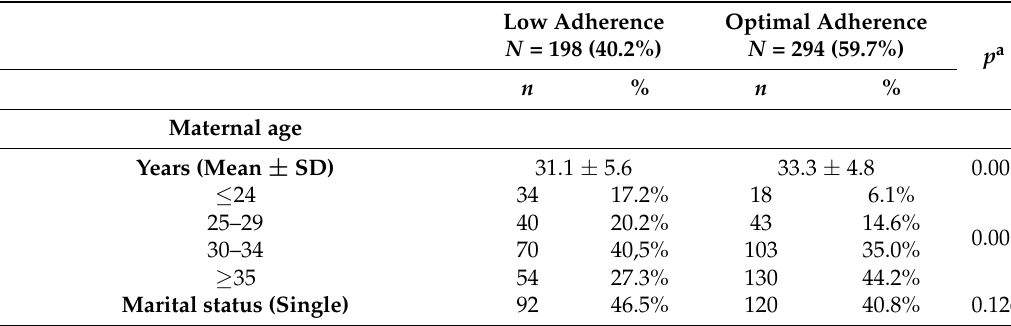
Table 1. Maternal sociodemographic